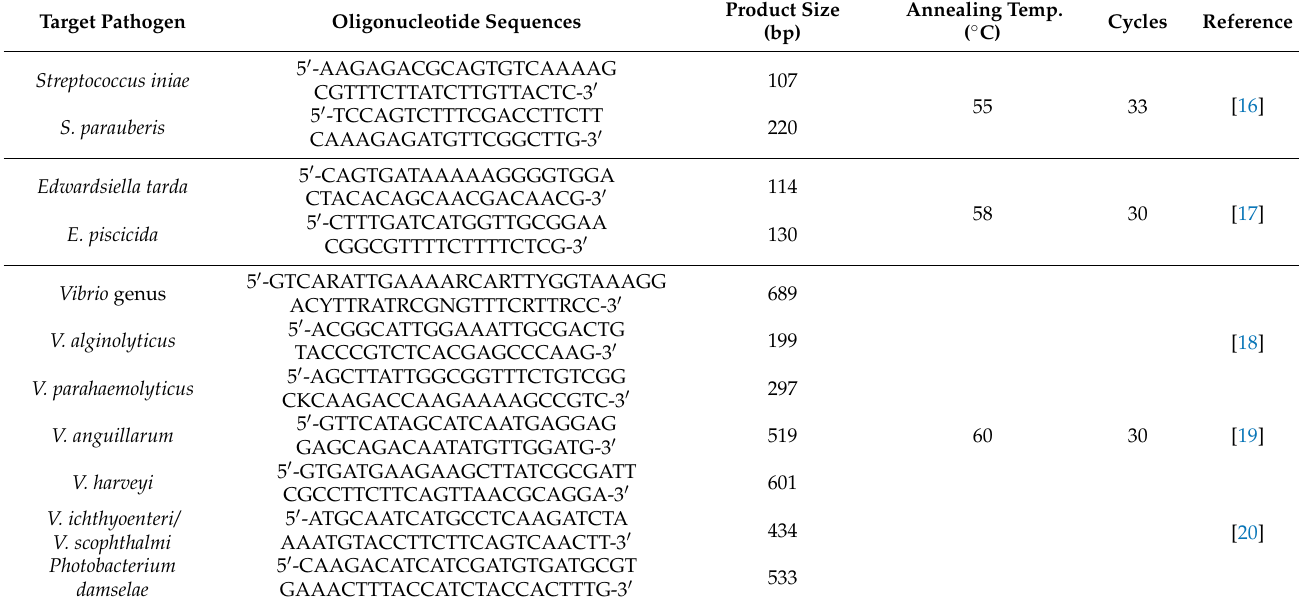
Table 1. Primer sets used for the detection of bacterial isolates in this study. Target Pathogen Oligonucleotide